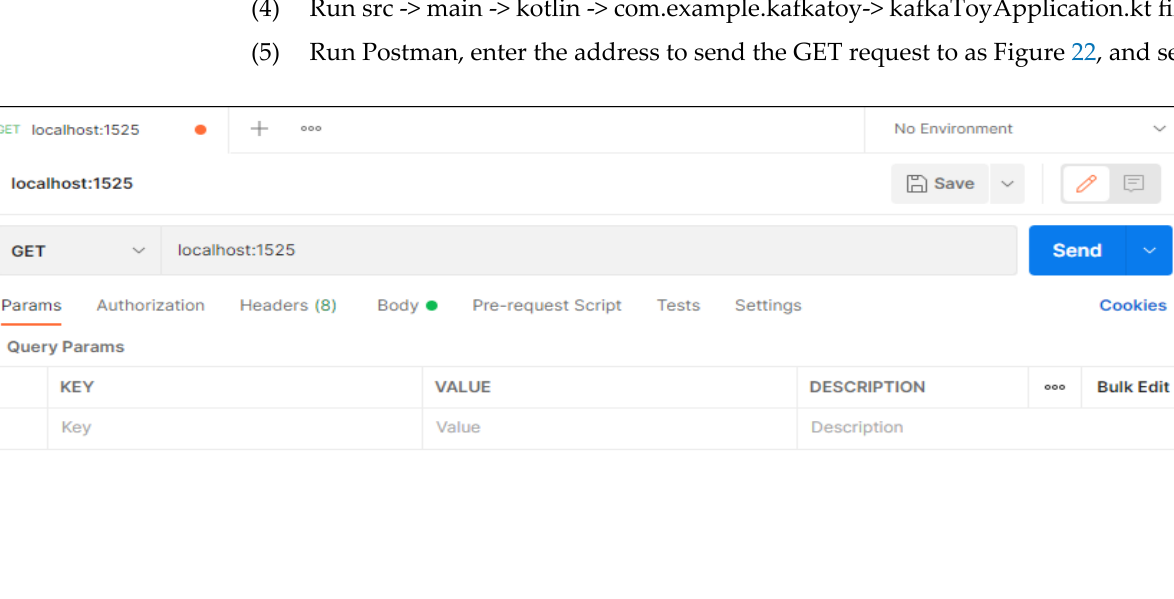
Figure 21. Source code of performance evaluation for main function.